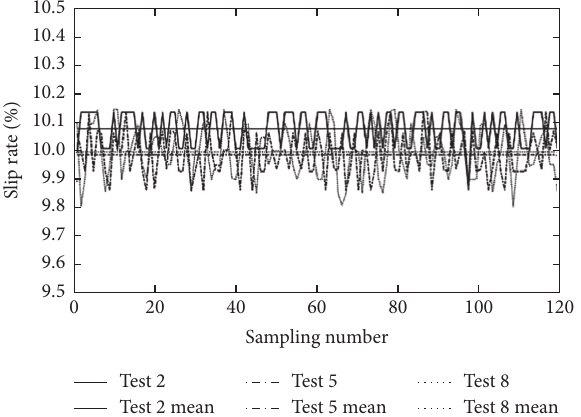
Figure 14: Tests 2, 5, and 8 slip rate statistics and mean curve.